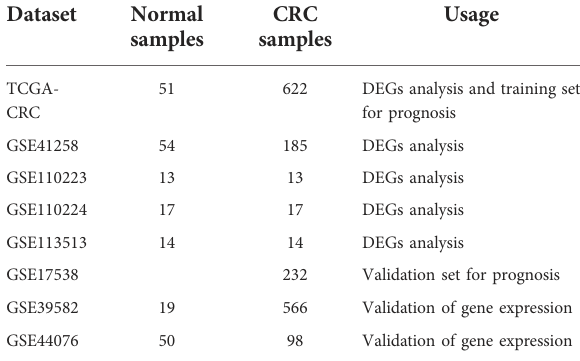
TABLE 1 Sample size and usage of the